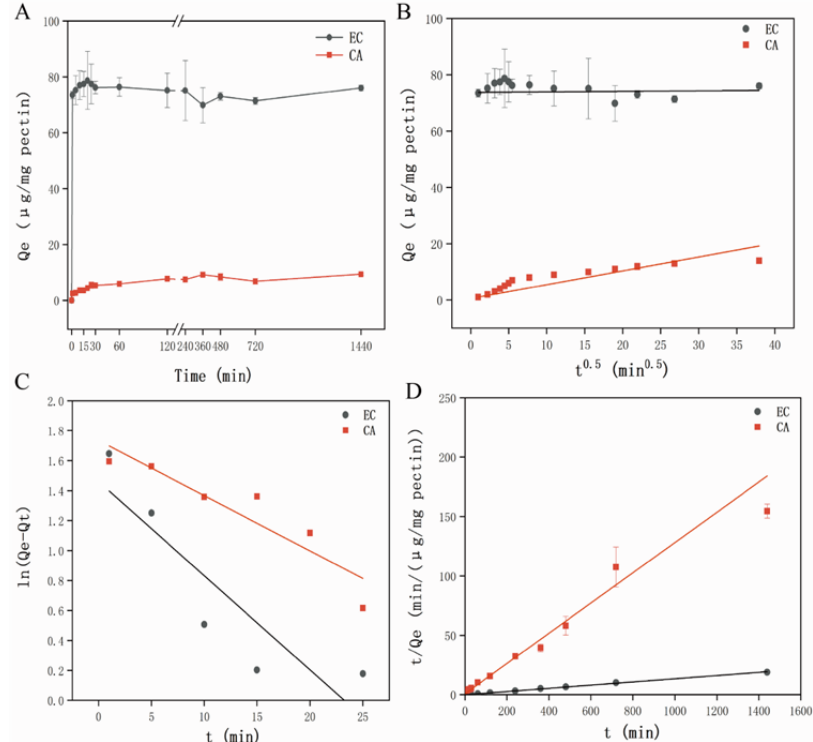
Figure 1. ( A ) Adsorption kinetics curves of EC and CA; ( B ) Intragranular diffusion equation fitting; ( C ) Pseudo-first order dynamic equation fitting; ( D ) Pseudo-second order dynamic equation. EC: epicatechin; CA: chlorogenic acid.